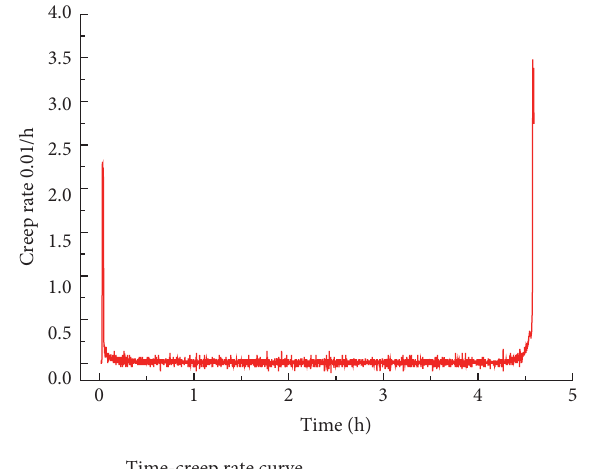
Time-creep rate